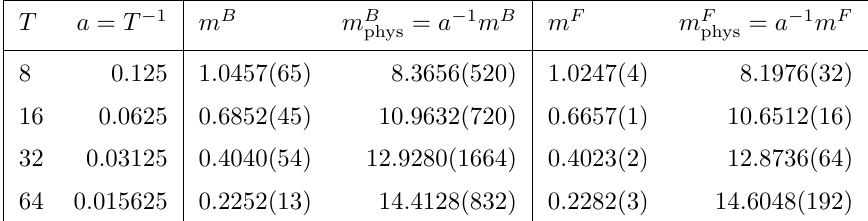
Table 1 . Bosonic and fermionic mass gaps for SUSY anharmonic oscillator. The parameters used are m phys = 10 and g phys = 100